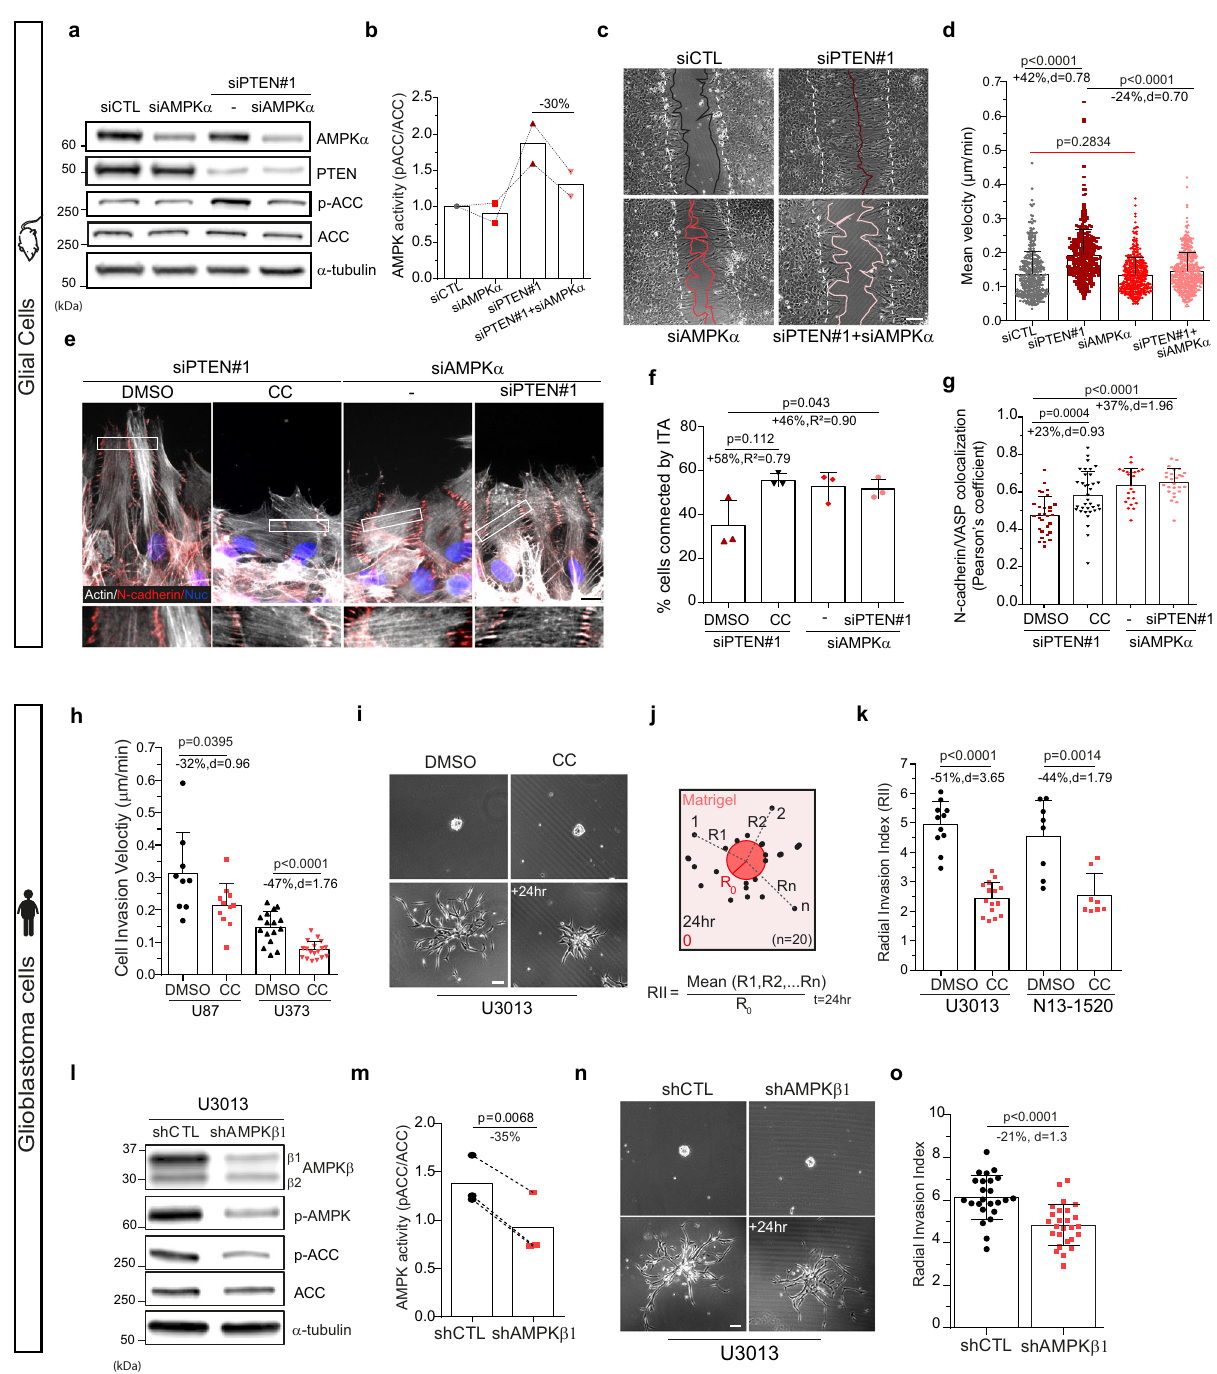
hypothesis, we used siRNA against AMPK α to decrease AMPK expression level and activity in PTEN-depleted cells (Fig. 5a, b; Supplementary Fig. 5a). In control primary astrocytes, AMPK α depletion did not affect signi fi cantly migration nor did it reduce ACC phosphorylation, which suggests that in these cells AMPK basal activity is low (Fig. 5a, b). In contrast, AMPK α depletion strongly reduced PTEN-depleted cells ’ ability to close the wound (Fig. 5c, Supplementary Movie 2). Cell tracking measurements showed that AMPK α depletion reduces the migration speed of PTEN-depleted cells by 24%, which corresponds to a 43% decrease of the increase caused by PTEN loss (Fig. 5d). Similar results were obtained when the regulatory subunit AMPK β was depleted in